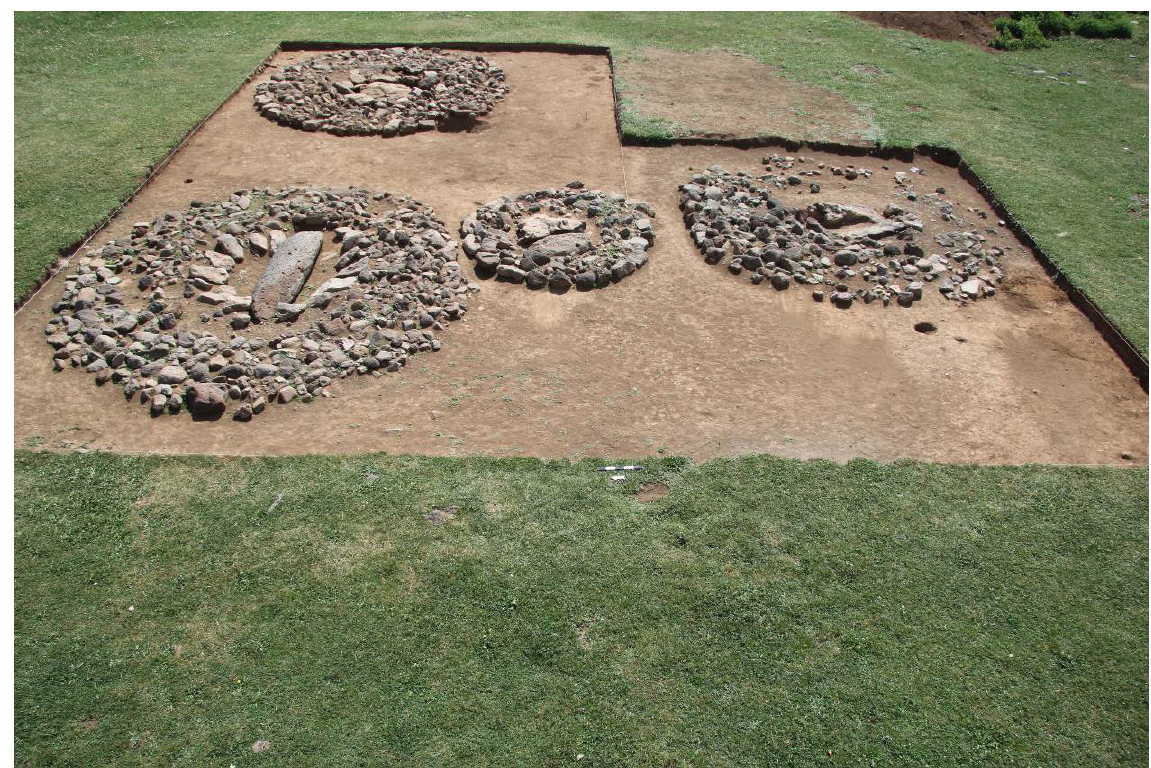
Figure 2. Cromlechs with re-used vishap (left) in KS A, facing East (photo by P. Hnila).